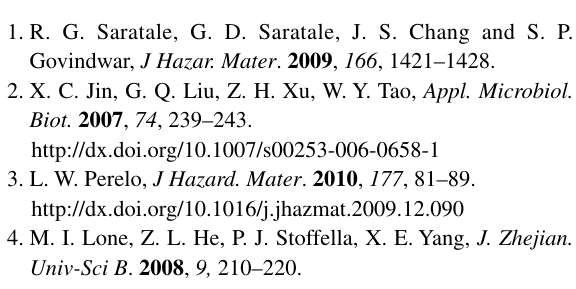
Fig. 7. TLC analysis of control dyes (CV and MG) and the de- graded metabolites after the phytoremediation experiments with CV (a) and MG (b) dyes (C = 100 mg/L, m = 3 g, V = 250 m- i plants L, initial pH = 3.5 (MG)/3.8 (CV), T = 23 ± 2 °C, until 12 days).